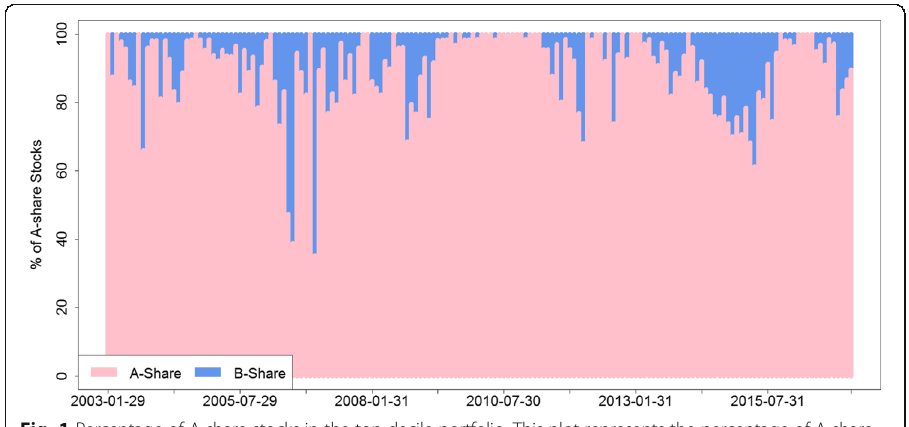
Fig. 1 Percentage of A-share stocks in the top-decile portfolio. This plot represents the percentage of A-share stocks (the vertical distance of the pink bar) at each time point in the study